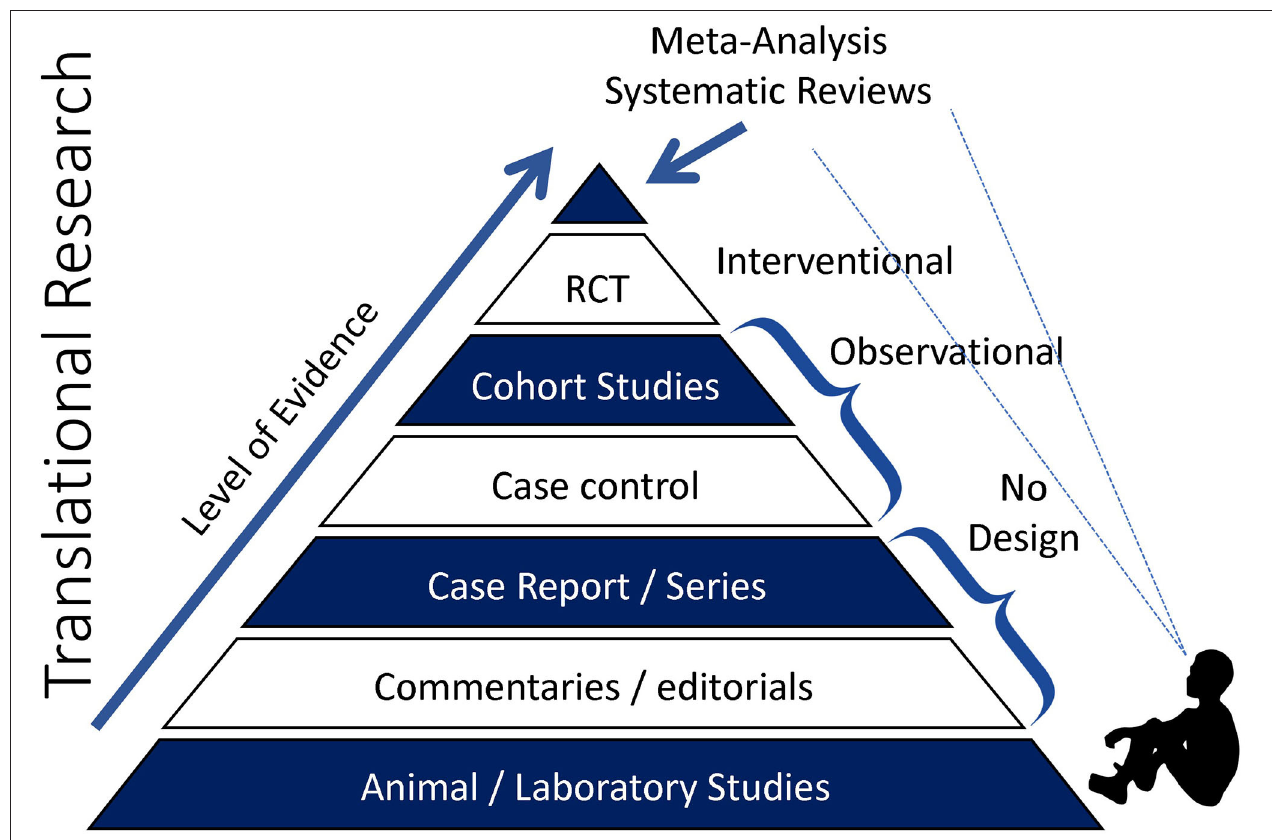
FIGURE 2 | Pyramid of clinical evidence. With respect to sedentary behavior-focused research and the capacity to develop sedentary behavior-reduction policy, we are currently sitting somewhere near the bottom of the pyramid peering up.